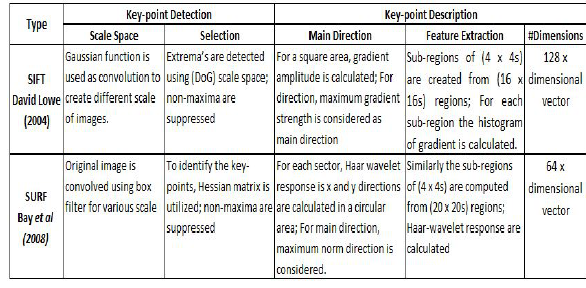
Figure 1. Comparison of SIFT and SURF Operators